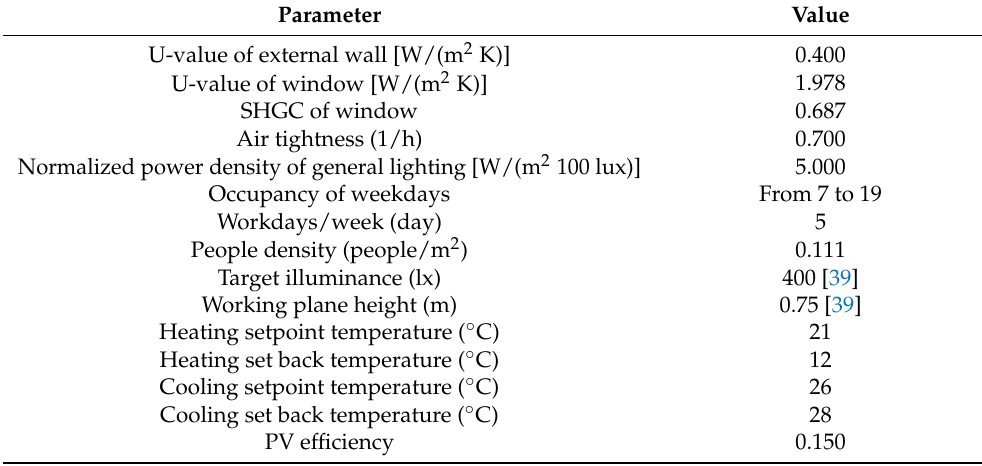
Table 3. Parameters of the energy-analysis model.